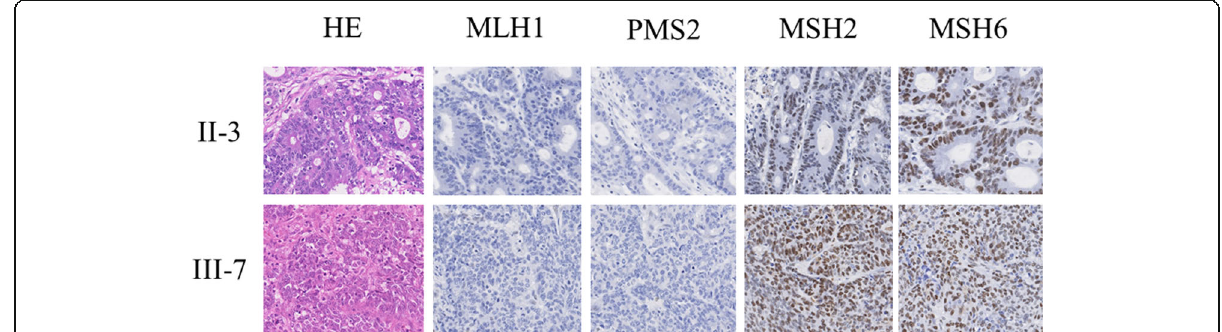
Fig. 3 Immunohistochemical staining for mismatch repair proteins of the colon tumors in this patient ’ s family. By immunohistochemistry, the tumor of this patient ’ s father; II-3 and brother; III-7 had an intact expression of MSH6. The rest of the mismatch repair proteins showed the same staining pattern of this patient; negative for MLH1 and PMS2, positive for MSH2